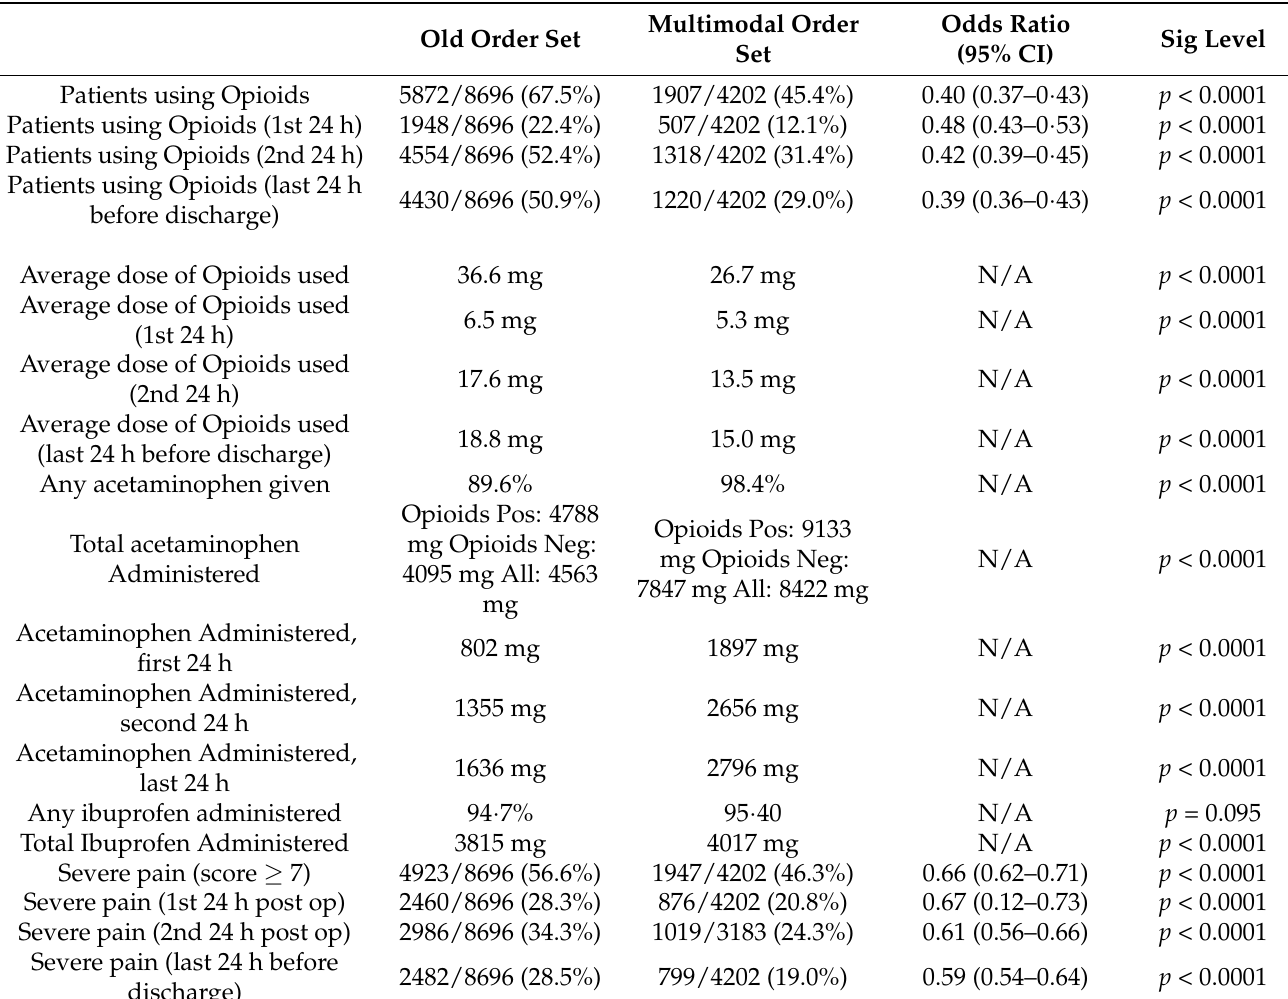
Table 3. Comparison of primary and secondary outcomes between the old and multimodal order set. Multimodal Old Order Set